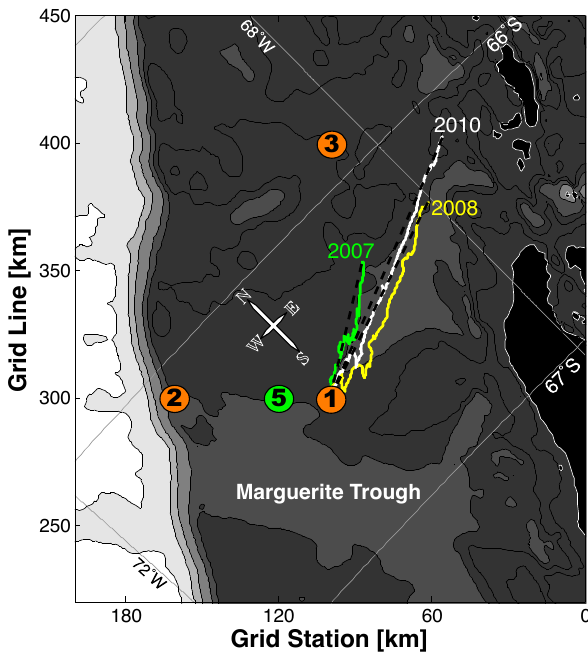
Fig. 6. Progressive vector diagram for the velocities at mooring site #1. If the flow observed at the mooring at all time steps was extended into a Lagrangian trajectory, the flow would track the northern wall of the Marguerite Trough’s NE fork (i.e., track the same bathymetry from the slope-shelf break). The vector lengths are scaled so as to fit onto the image.